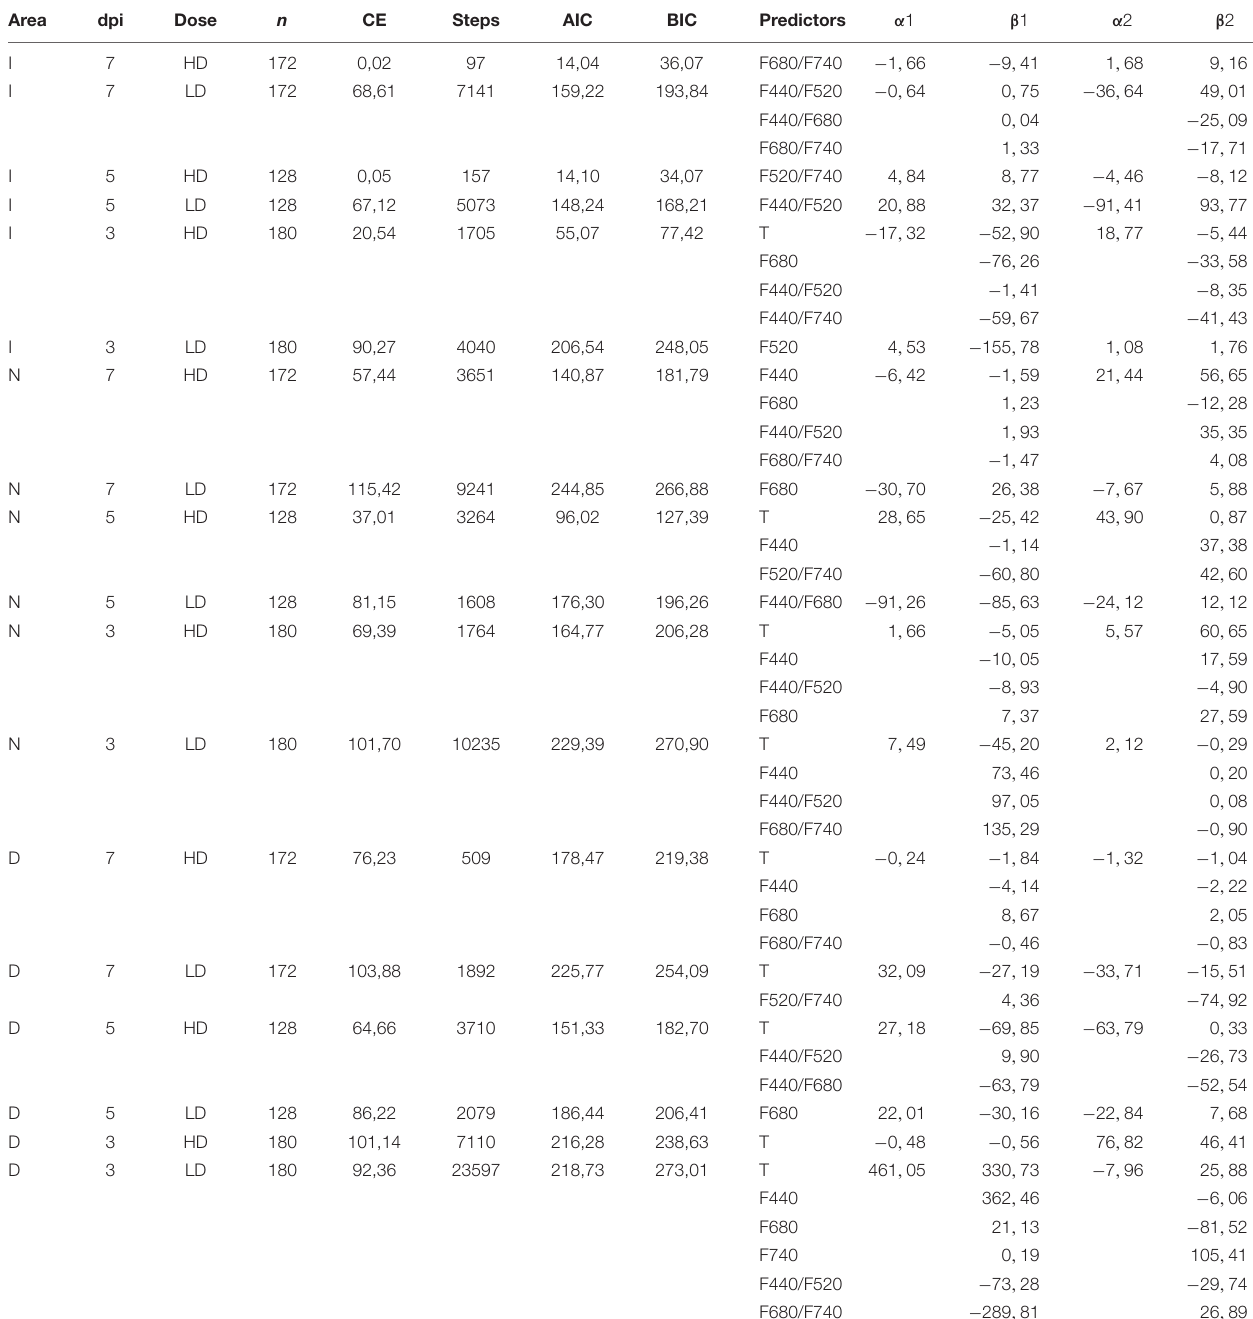
TABLE 2 | Artificial neural networks (ANN) models for the prediction of healthy and D. dadantii infected zucchini leaves.